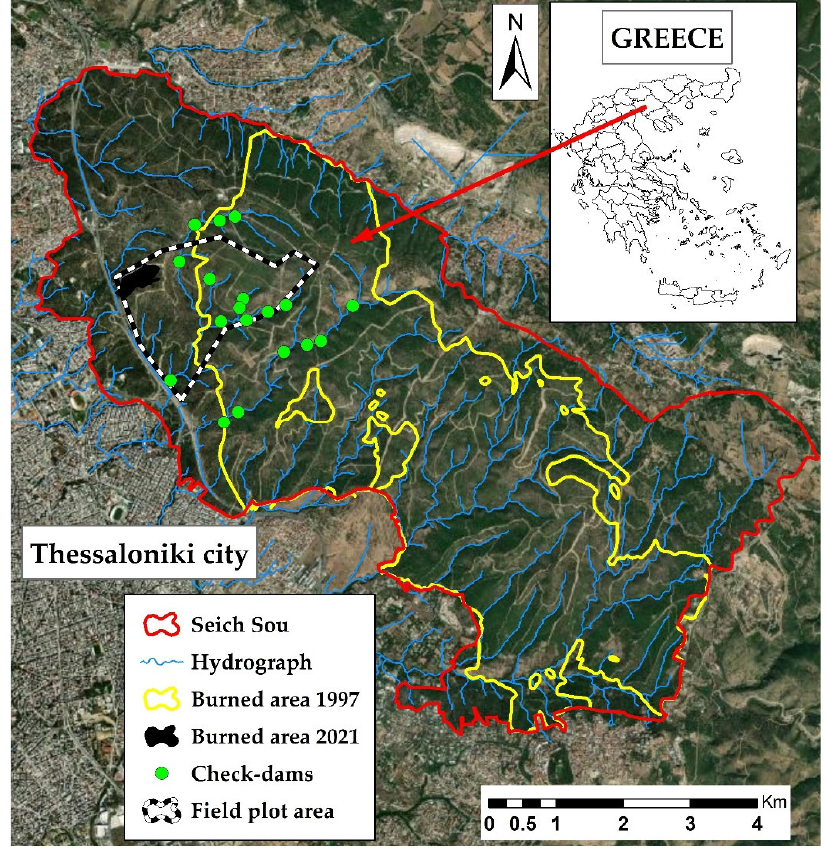
Figure 1. Study area. Thessaloniki suburban forest (Seich Sou).